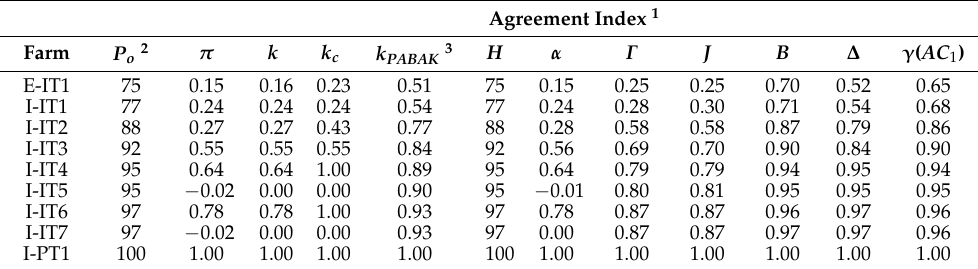
Table 1. Values of the agreement indexes for the AWIN animal-based welfare indicator “udder asymmetry” for the nine selected dairy goat farms, sorted by increasing concordance rate ( P 0